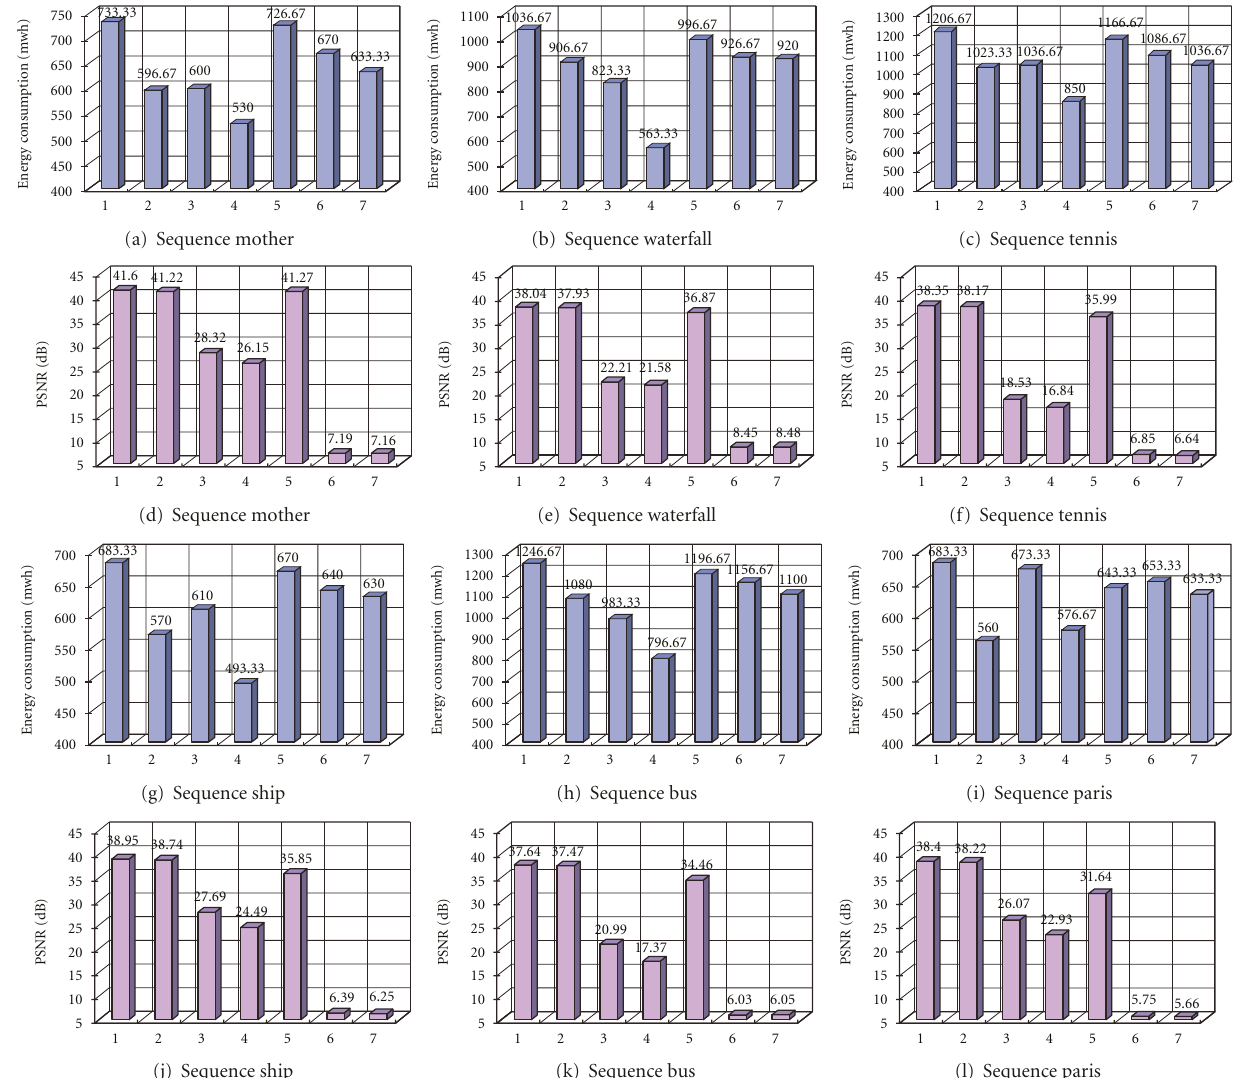
Figure 6: Stat. on energy consumption and PSNR for di ff erent video sequences in each decoding